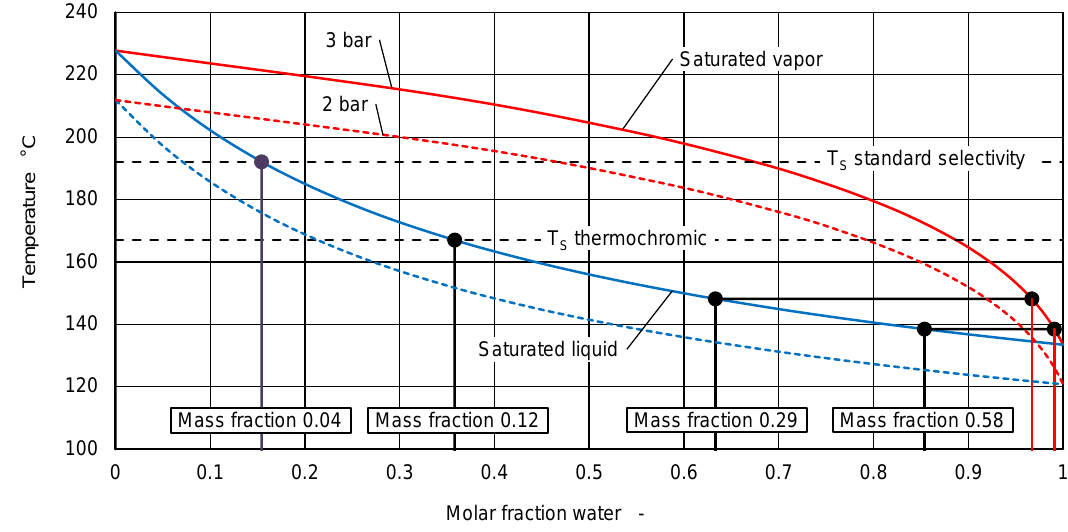
Figure 6. Phase diagram of water propylene glycol at three bar absolute pressure.